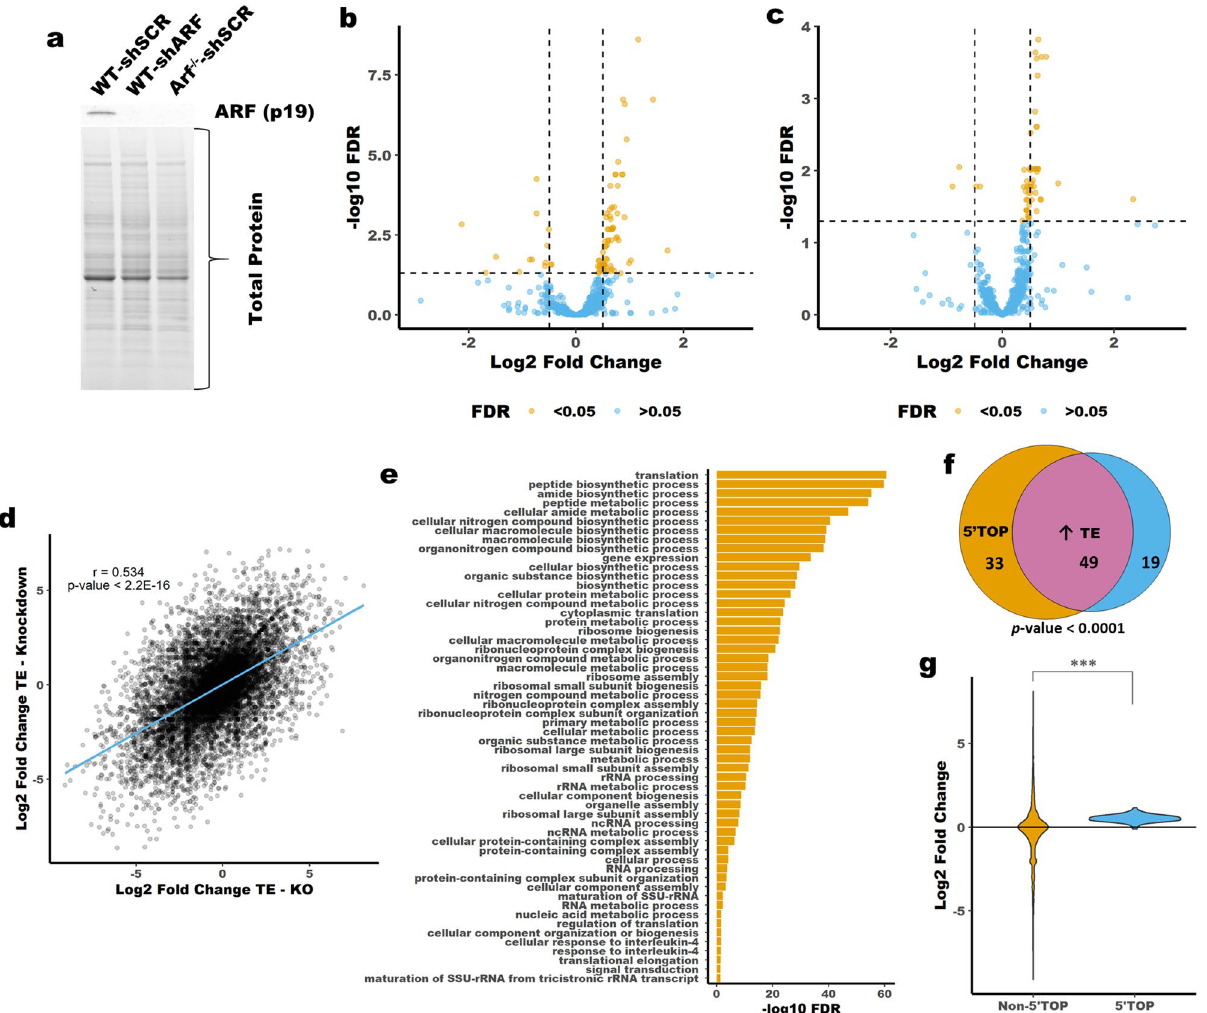
Figure 2. Ribosome profiling reveals upregulation of 5 ′ -TOP mRNA translation following loss of ARF. ( a ) Immunoblot showing knockdown and knockout of Arf in MEFs. ( b ) Volcano plot showing Log2 Fold Change of TE between WT-shSCR and Arf −/− -shSCR MEFs or WT-shSCR and WT -shARF MEFs ( c ) Vertical lines are Log2 Fold Change of ± 0.5. Horizontal line is FDR corrected p -value of 0.05. ( d ) Correlation between Fold Change of TE following ARF knockout (x-axis) or ARF knockdown (y-axis). ( e ) Geno ontology terms associated with genes that have increased TE following ARF knockout. ( f ) Venn-diagram showing overlap between mRNAs with increased TE and the presence of a 5 ′ -TOP motif. ( g ) Violin plot showing the TE of mRNAs known to contain a 5 ′ -TOP motif versus those that are not known to contain the motif 21 . *** p -value < 0.00001; Hypergeometric test ( f ) or two-tailed t-test ( g